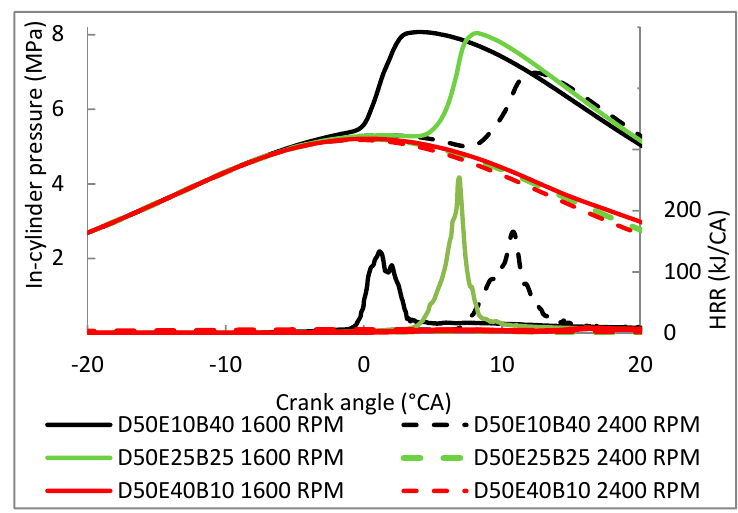
Figure 4. Graph of in-cylinder pressure and heat release rate (HRR) of D50E10B40, D50E25B25, and D50E40B10 blends at 1600 RPM and 2400 RPM.